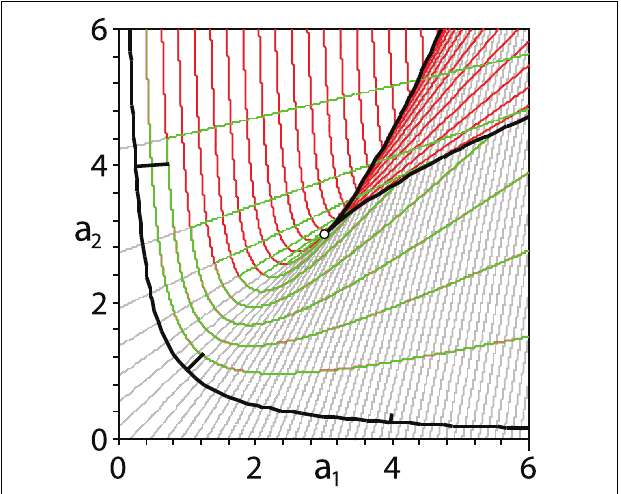
FIGURE 9 | The green curves show the contour plot (decrement diagram) of the abscissa a of the cubic polynomial (22) with contour plots of the real parts of the inactive roots superimposed (red and gray curves). The open circle marks the location of the EP 3 singularity of the bifurcation diagram, where the abscissa reaches its minimum. The contours corresponding to simple real roots are straight lines that sweep out the cuspidal area confined between the boundaries of the bifurcation diagram. In the limit, these contours are tangent to the black cuspidal curve and may be viewed as rays forming a caustic [19, 42, 44]. The curved green contours correspond to real parts of a complex conjugate pair of eigenvalues. The black hyperbola marks the stability boundary with the stable region above it and to the right. Along the stability boundary, a few (negative) gradient vectors of the real part of the complex conjugate pair of active eigenvalues are marked at a 1 = 0 . 25, a 1 = 1, and a 1 = 4.